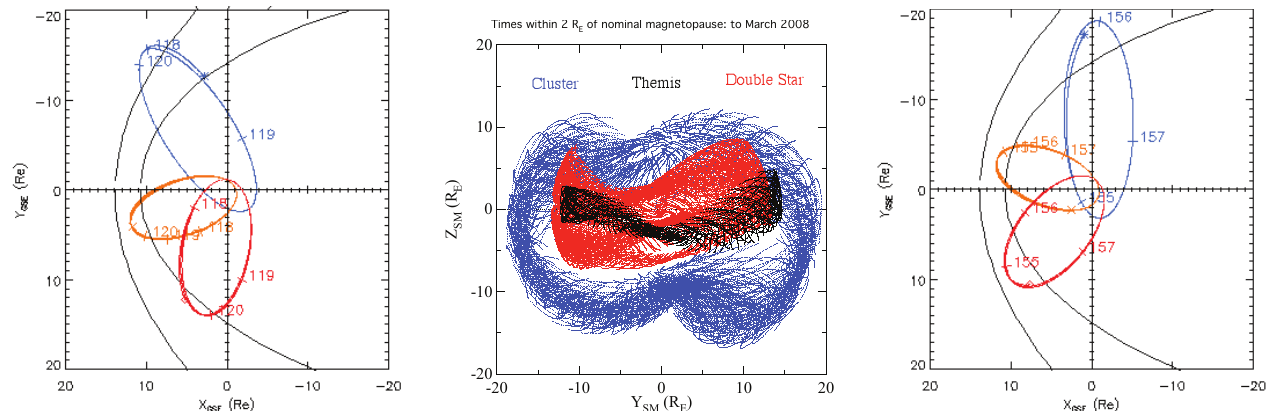
Fig. 1. Configuration of the Cluster, TC-1 and THEMIS spacecraft during the epoch April–August 2007. The left hand panel shows the early orientation with the five THEMIS spacecraft on the dusk-side magnetosphere (red orbits), TC-1 near noon (orange orbit) and the four Cluster spacecraft on the dawn-side magnetosphere (blue orbits). One obit track is drawn in the cases of Cluster and THEMIS. The right hand panel shows the orientation at the end of the phase and the centre panel shows the overall coverage across the magnetopause, as seen from the